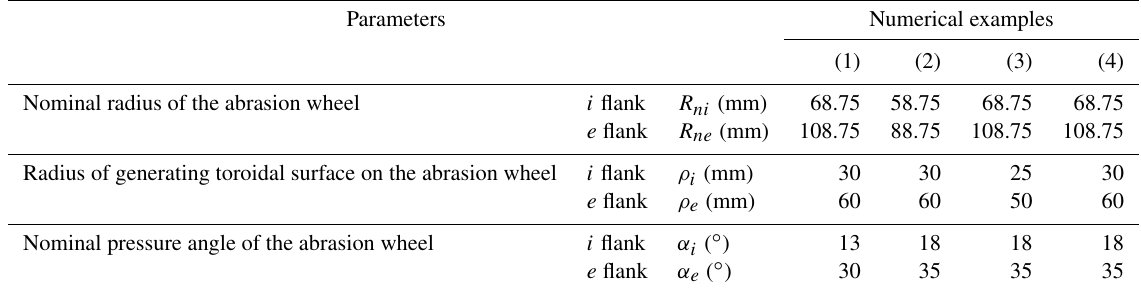
Table 2. Geometric parameters of the abrasion wheel in each numerical example.